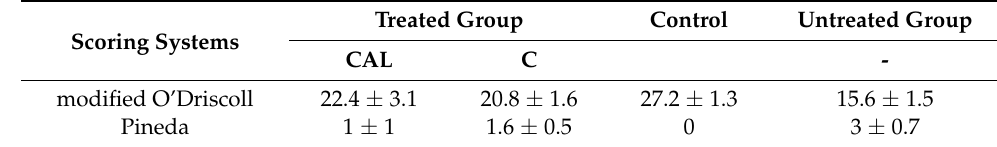
Table 2. The total mean histological scores (mean ± SD).